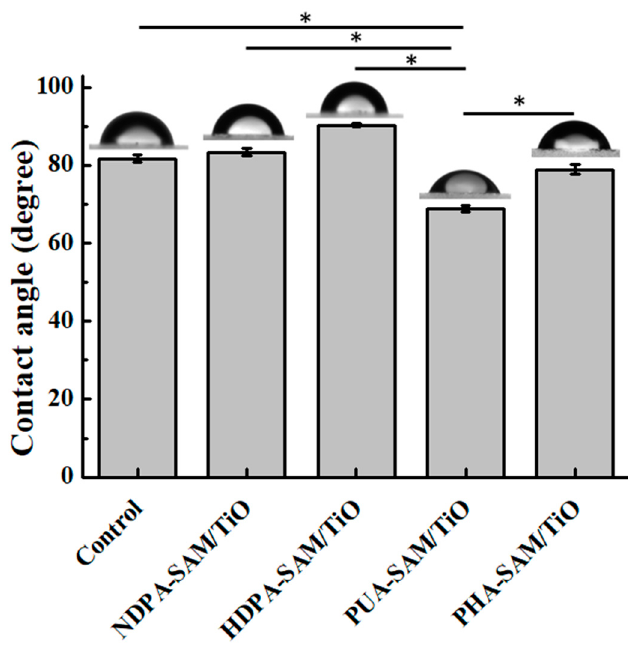
Figure 6. The average contact angle results of the investigated samples (* p < 0.05).